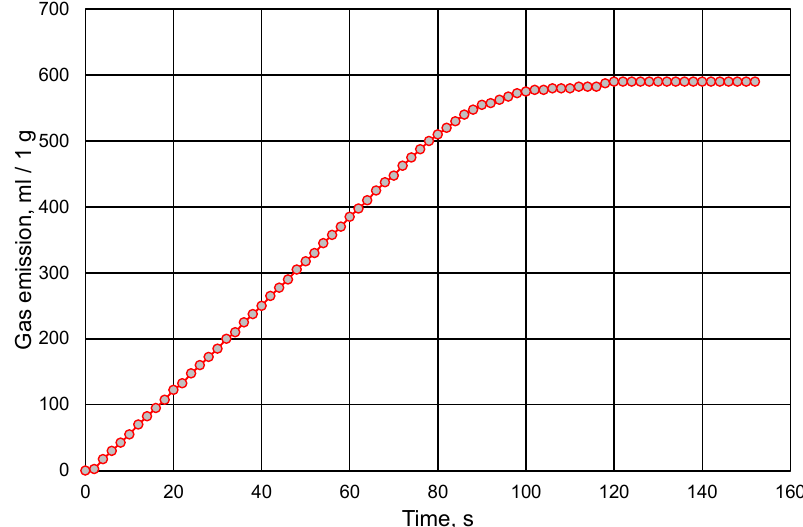
Figure 7. Measurement of Permabind resin gas emission.